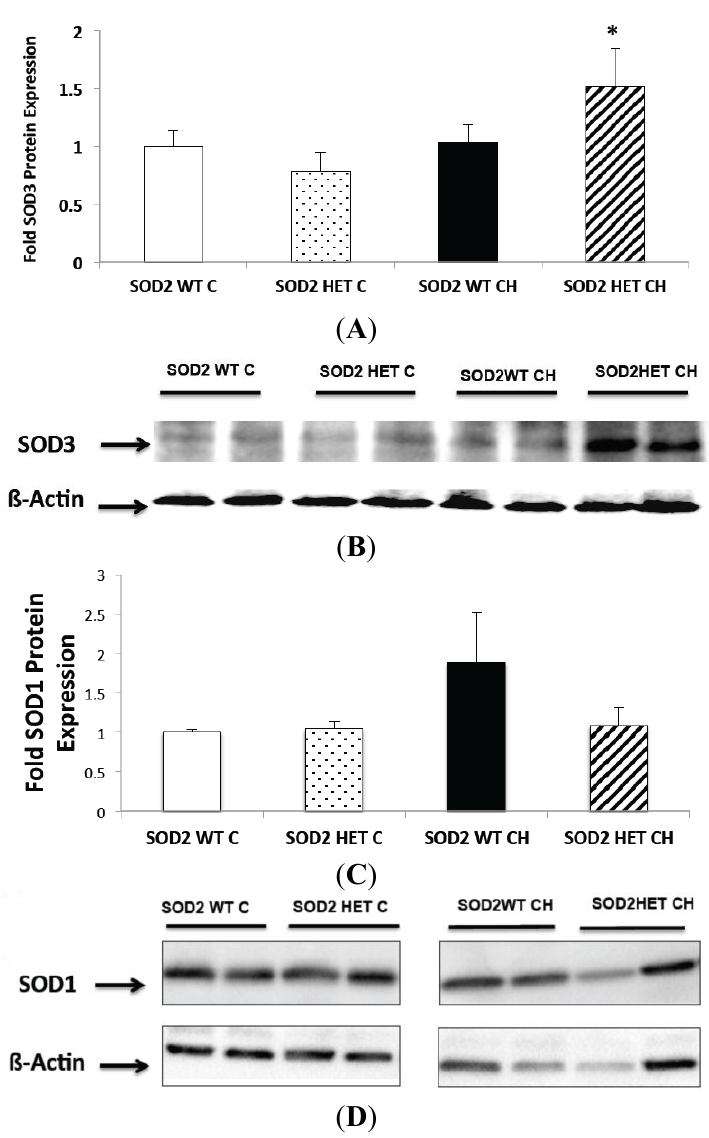
Figure 7. Chronic hyperoxia (CH) exposure increased SOD3 expression in SOD2−/+ mice but does not change SOD1 expression. Neonatal mice (SOD2−/+ (HET) and isogenic SOD2+/+ (WT) littermates) were exposed to chronic hyperoxia (CH) or room air (Control (C)) from birth to 14 days of life. Mice were euthanized on day 14, and lung tissue was harvested. ( A ) Lung SOD3 protein expression was measured by Western blot from WT and HET mice. Data are shown as fold mean ± SEM ( n = 8; * p < 0.05 vs. SOD2 HET C); ( B ) Representative Western blots of SOD3 expression is shown with corresponding β-actin; ( C ) Lung SOD1 protein expression was measured by Western blot from WT and HET mice. Data are shown as fold mean ± SEM ( n = 6); and ( D ) Representative Western blot of SOD1 expression is shown with corresponding